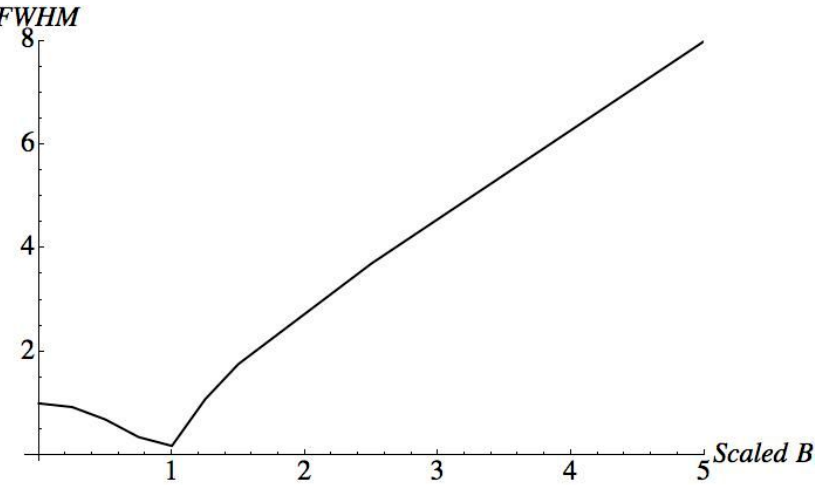
Figure 8. The Full Width at Half Maximum (FWHM) of the theoretical profile of hydrogen/deuterium Ly-beta line observed perpendicular to the magnetic field B with a polarizer along B . The scaled magnetic field is the ratio of the Lorentz-field shift to the Doppler shift. The FWHM is in units of the Doppler half width at half maximum. The narrowing effect is the most pronounced when the Lorentz-field shift is equal to the Doppler shift [66].